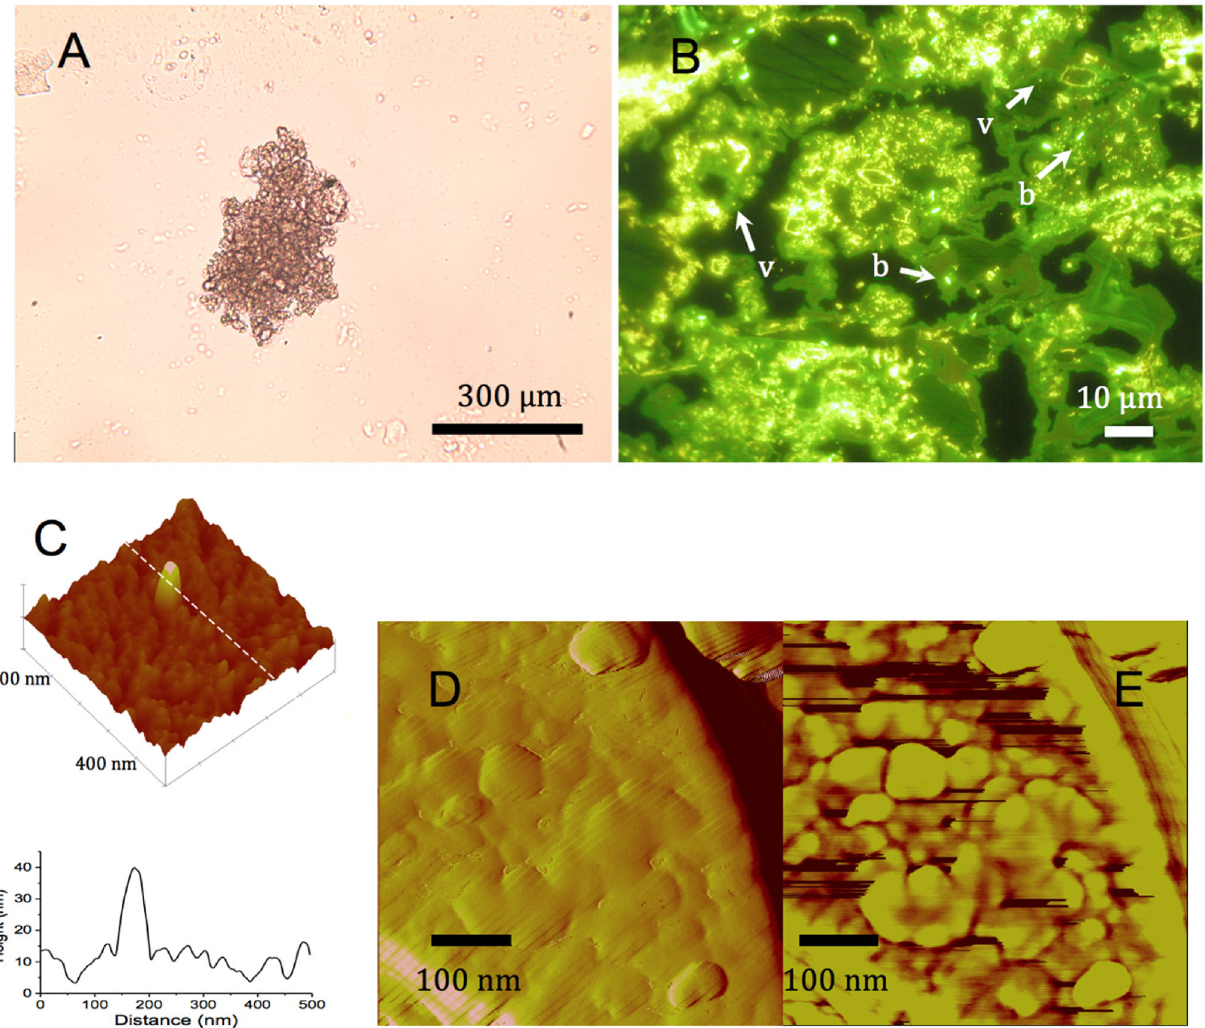
Fig 4. A: Biogenic high-Mg calcite minerals observed under light microscopy (phase contrast). B: Light micrograph of the carbonate crystal section stained with the nucleic acid dye SYBR Gold showing specific yellow-green fluorescence of bacteria (b) and viruses (v). C: three-dimensional presentation of an AFM image of a section of a biogenic calcium carbonate mineral showing a topographic anomaly caused by an included particle emerging 30 – 40 nm above the crystal surface interpreted as a viruses, the panel also includes a topographic presentation along the broken white line. D: AFM height image of a 500 × 500 nm surface area of a biogenic calcium carbonate grain. E: same area as in panel D but according a phase image